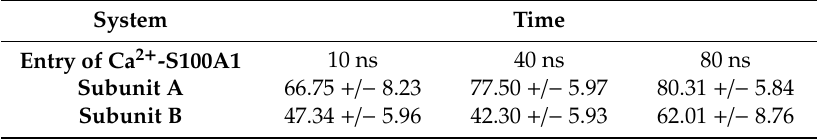
Table 3. The experiment of entry of four Ca 2 + from the bulk for each simulation is approximated between the H3 site, the EF site, and H4 topology in the respective time intervals for each subunit. Angles are calculated according to the same residues, as directed by the yellow line of Figure 3.